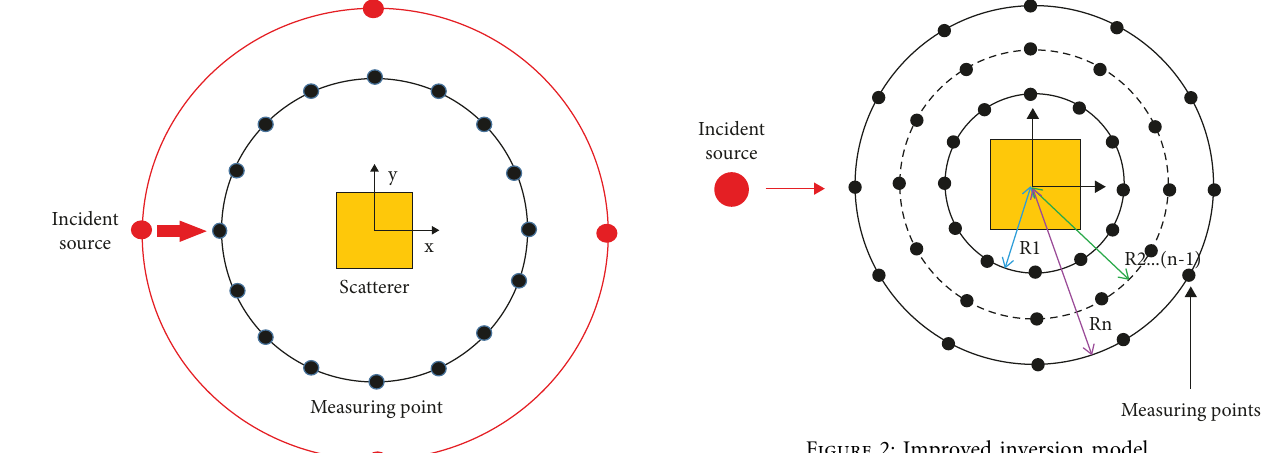
Figure 2: Improved inversion